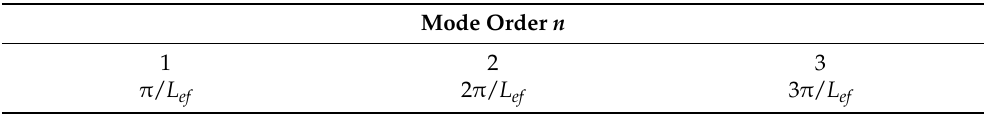
Table 2. Reference wavenumbers β n for monolithic beams with simply supported ideal end restraints and bending span L ef